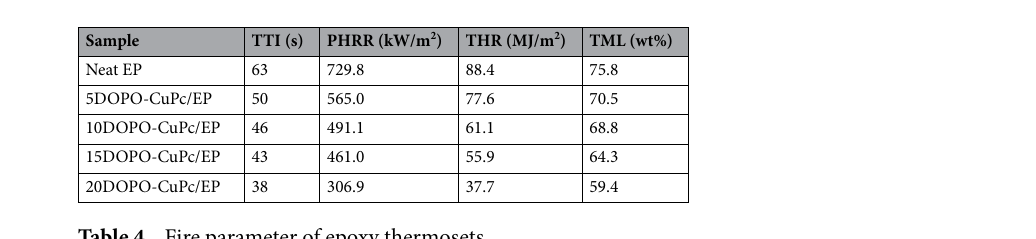
Table 4. Fire parameter of epoxy thermosets.